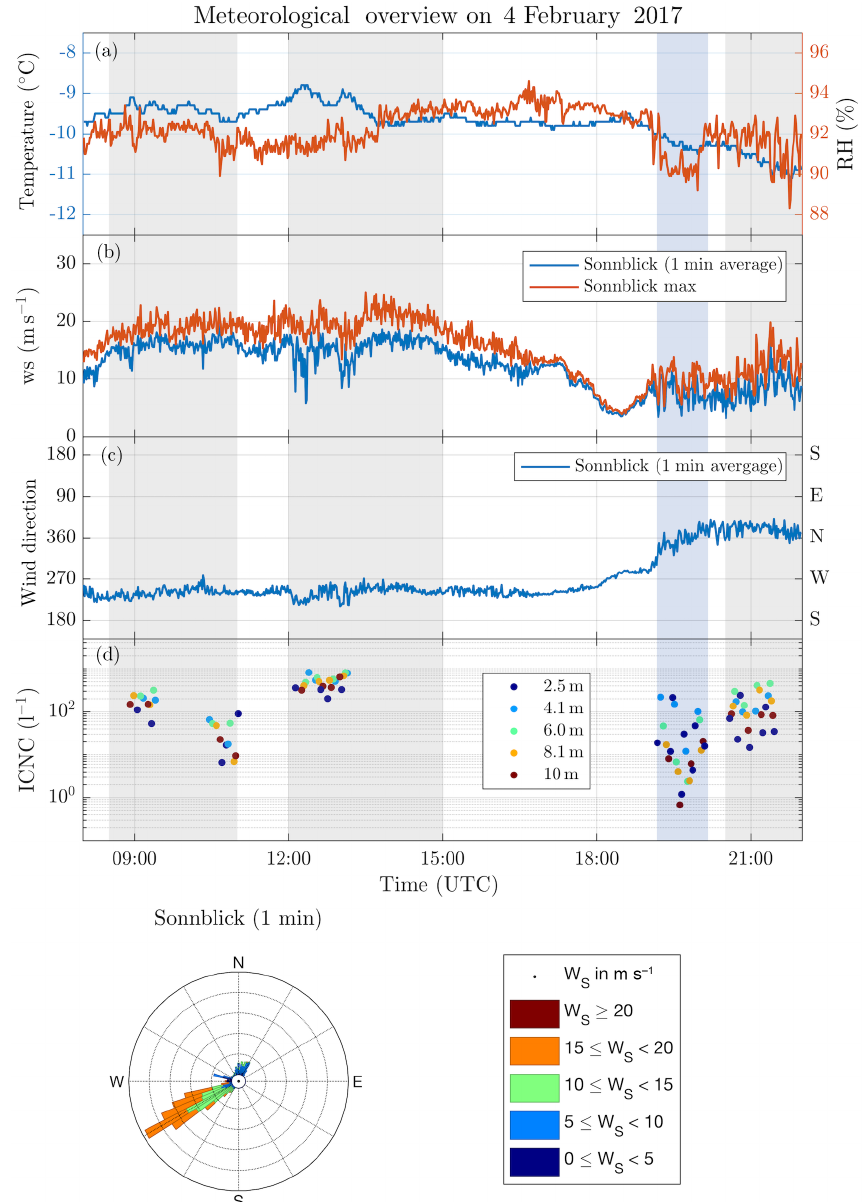
Figure 4. Overview of the meteorological and microphysical parameters on 4 February 2017. Meteorological measurements are 1min averages except for the maximum wind speed (ws), which corresponds to the maximum wind speed observed during a 1min average. The shaded areas represent intervals with ice crystal measurements with the SBO in cloud (gray) and not in cloud (blue). Shown are the temperature and relative humidity (a) , wind speed (b) and wind direction (c) . A wind rose plot is shown in the bottom panel. The ICNC measurements (d) are averages for each height level during a single